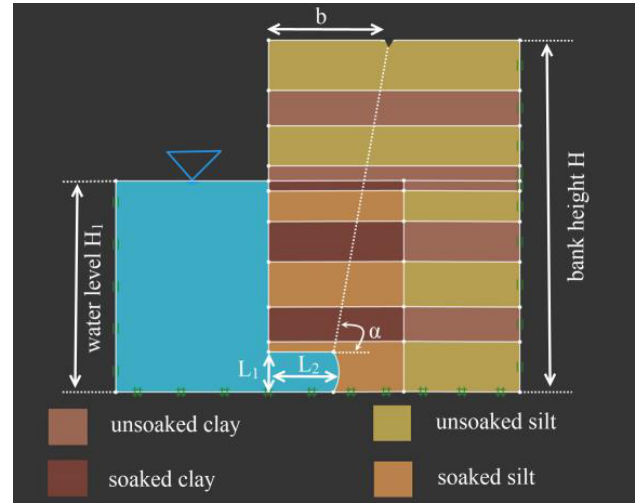
Figure 9. Generalized model of the bank collapse.